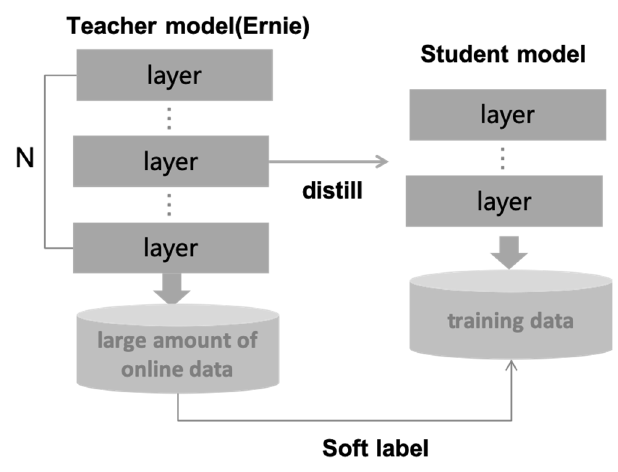
Figure 2. Structure of BERT model.